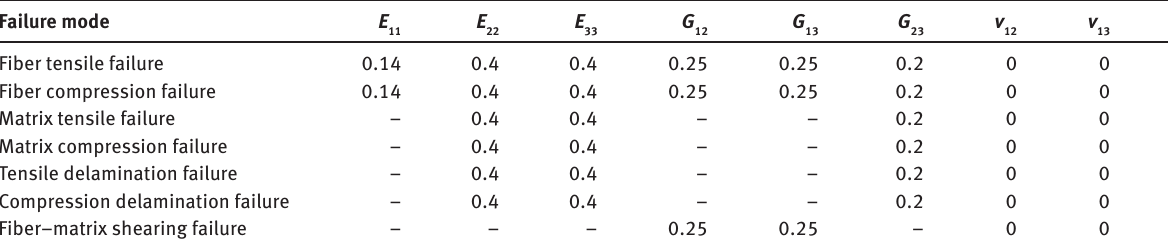
Table 4: Stiffness degradation rule for Olmedo failure criteria [14].